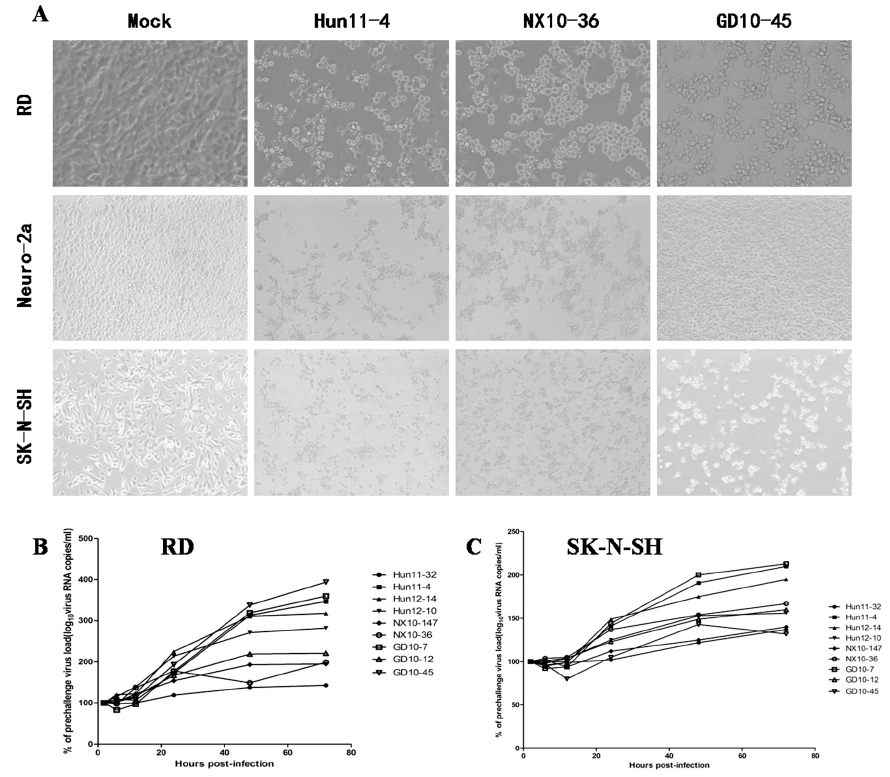
Figure 1. Enterovirus 71 (EV71) strain infection and replication in rhabdomyosarcoma (RD) cells,